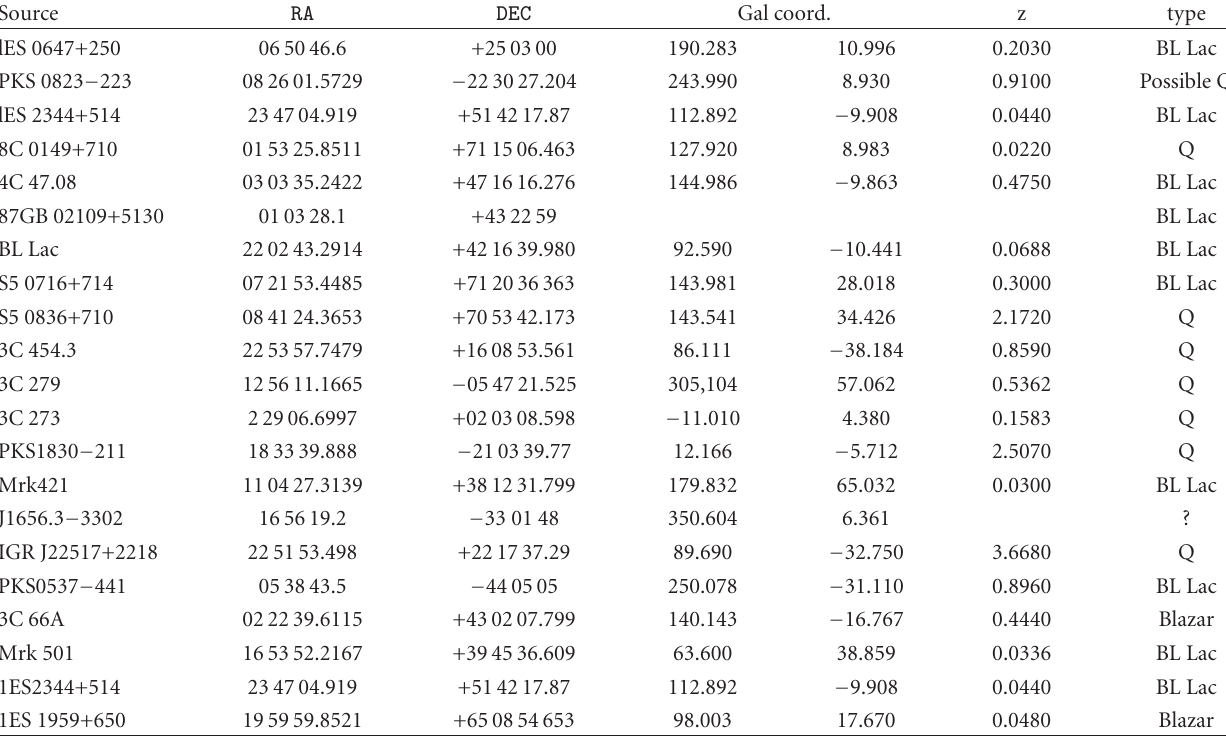
Table 3: List of blazars observed by the INTEGRAL satellite in hard